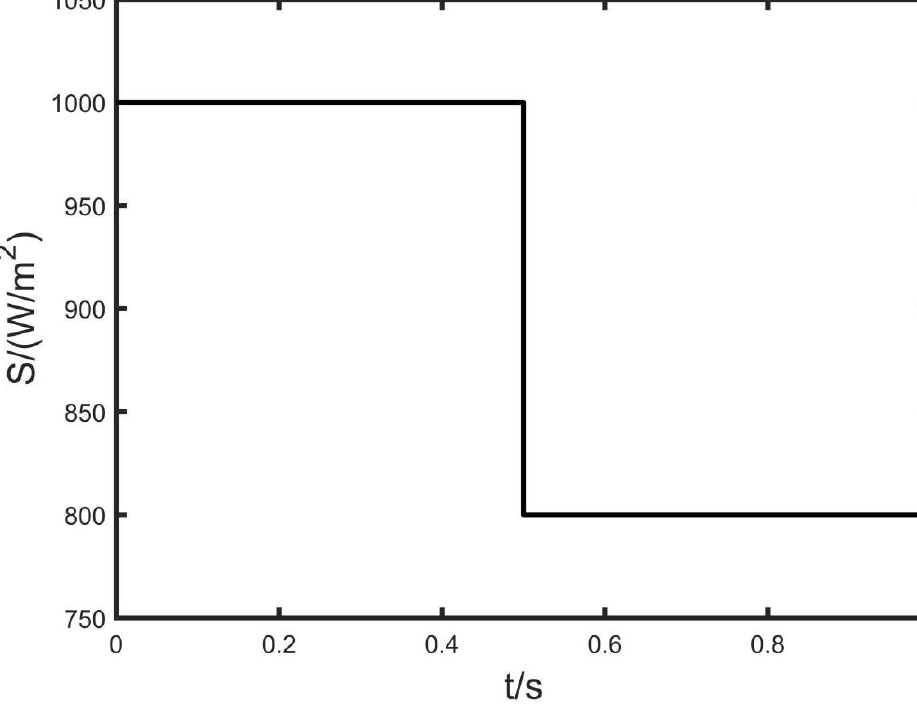
Figure 13. Variation curve of photovoltaic cell PV1 light intensity.